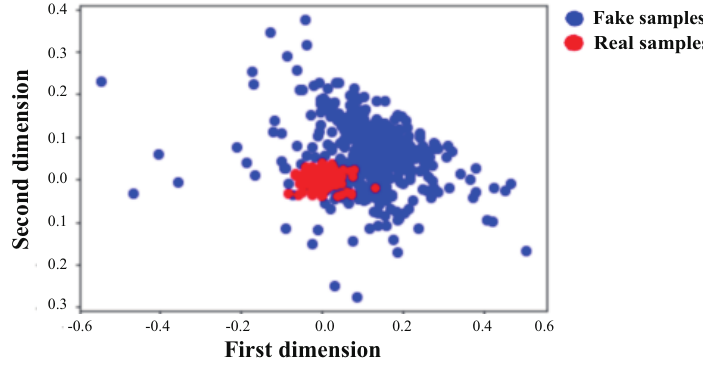
Figure 9. Feature distribution of the unstable